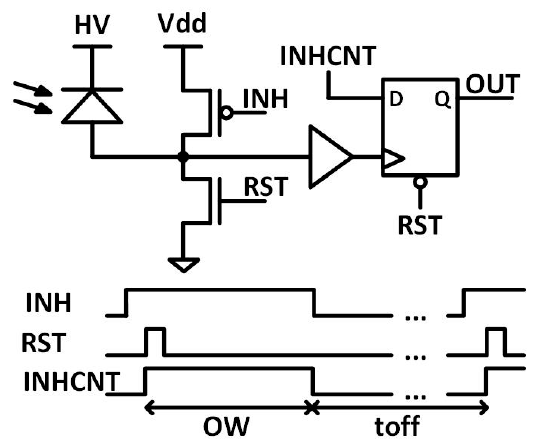
Figure 4. SPAD pixel schematic and time diagram of SPAD control signals.